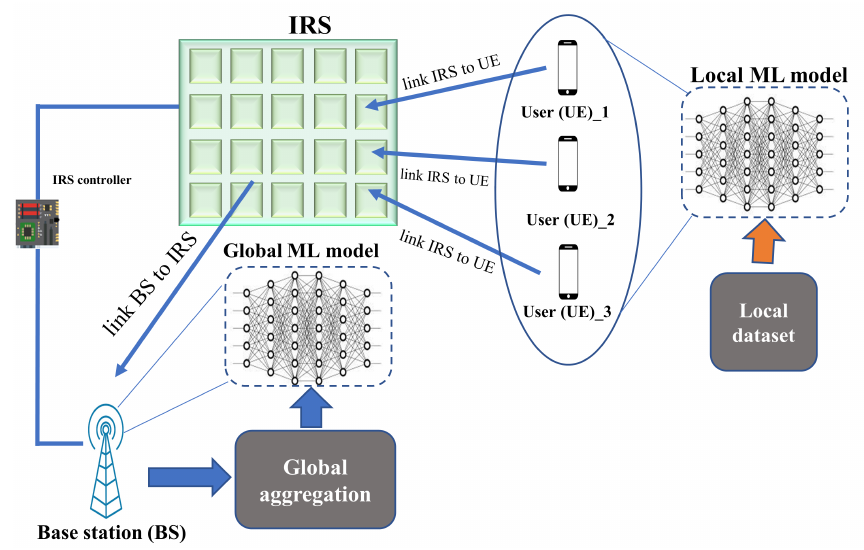
Figure 9. FL-based IRS-enhanced communication system.